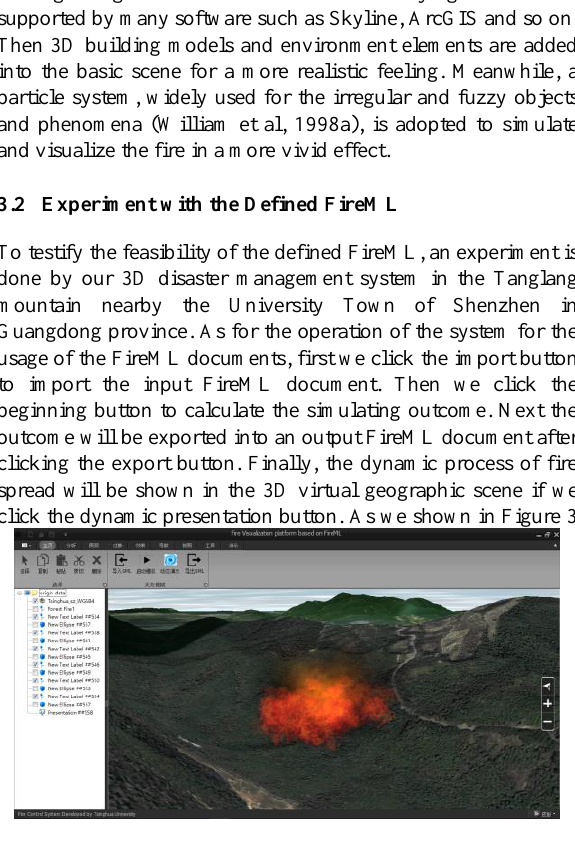
Figure 3. The dynamic process of fire spread in 3D